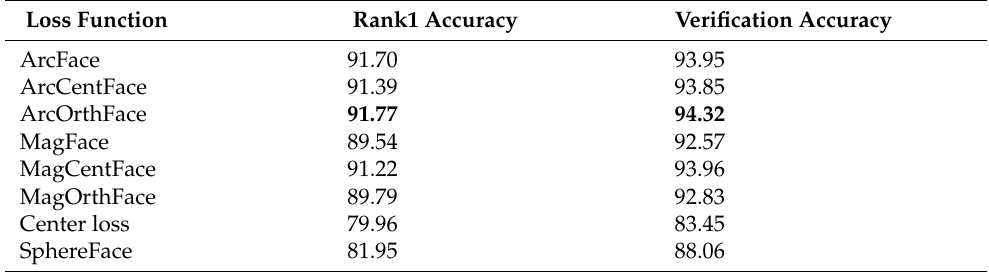
Table 4. Identification and Verification Results (%) on MegaFace with Various Loss Functions.